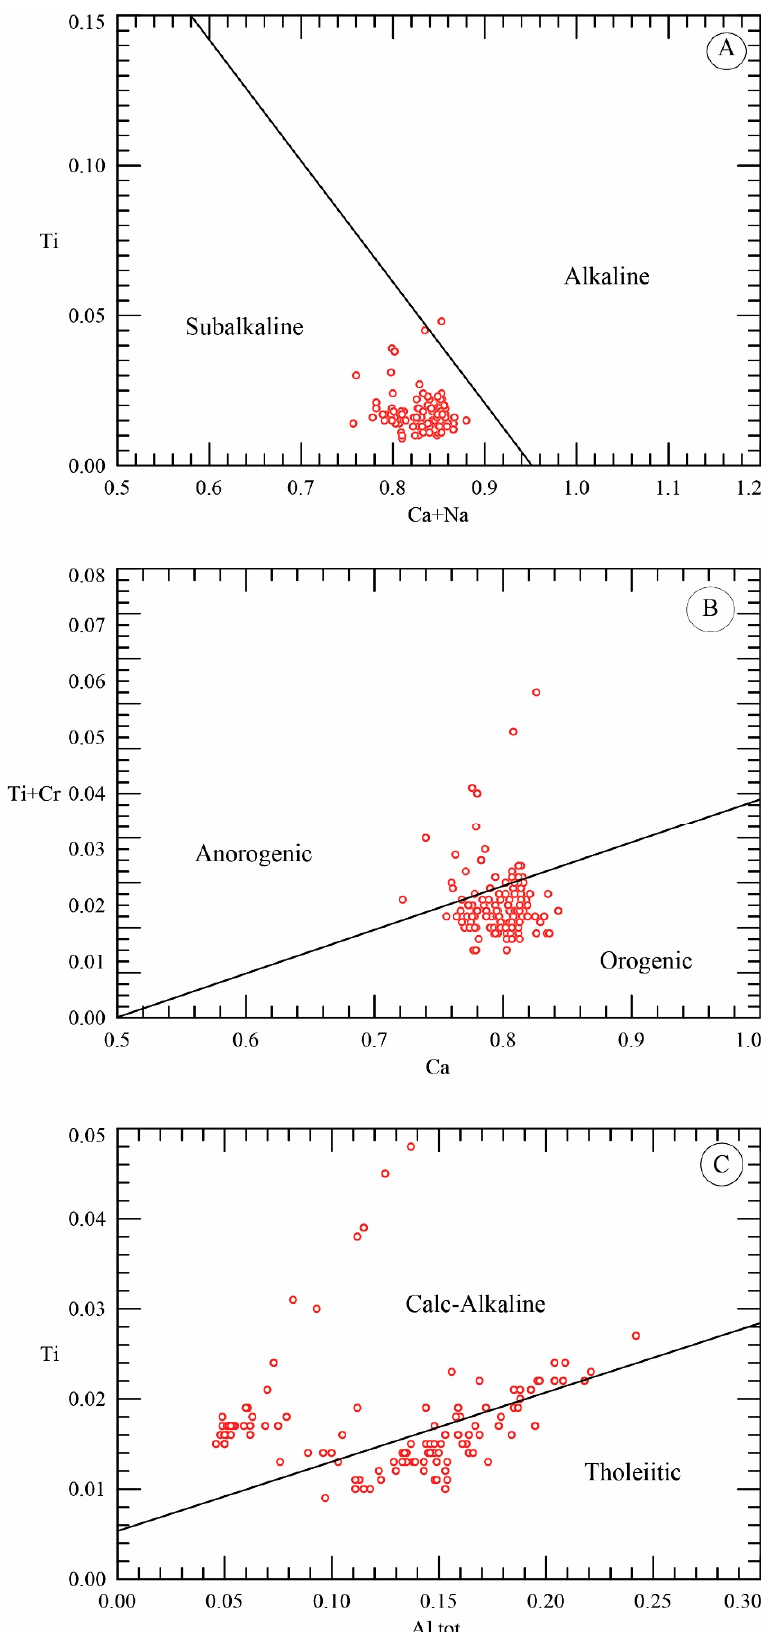
Figure 15. Distribution of the studied clinopyroxenes in three different diagrams: ( A ) Ca + Na–Ti, ( B ) Ca–Ti + Cr, ( C ) Altot–Ti of [63]. Red circles indicate the analyzed clinopyroxenes.